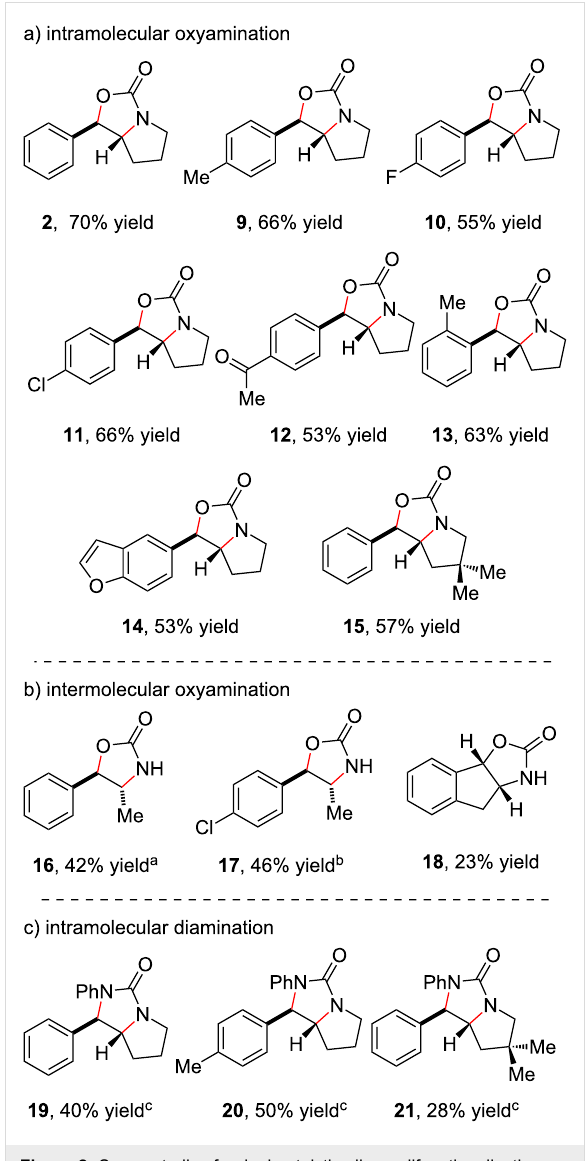
Figure 2: Scope studies for dual-catalytic alkene difunctionalization using 2.5 mol % 3 , 30 mol % Cu(TFA) 2 , and a 15 W blue flood lamp. Diastereomer ratios >20:1 unless otherwise noted. a 3:1 dr. b 10:1 dr. c Reaction conducted using MesAcrMe + ( 6 ) as